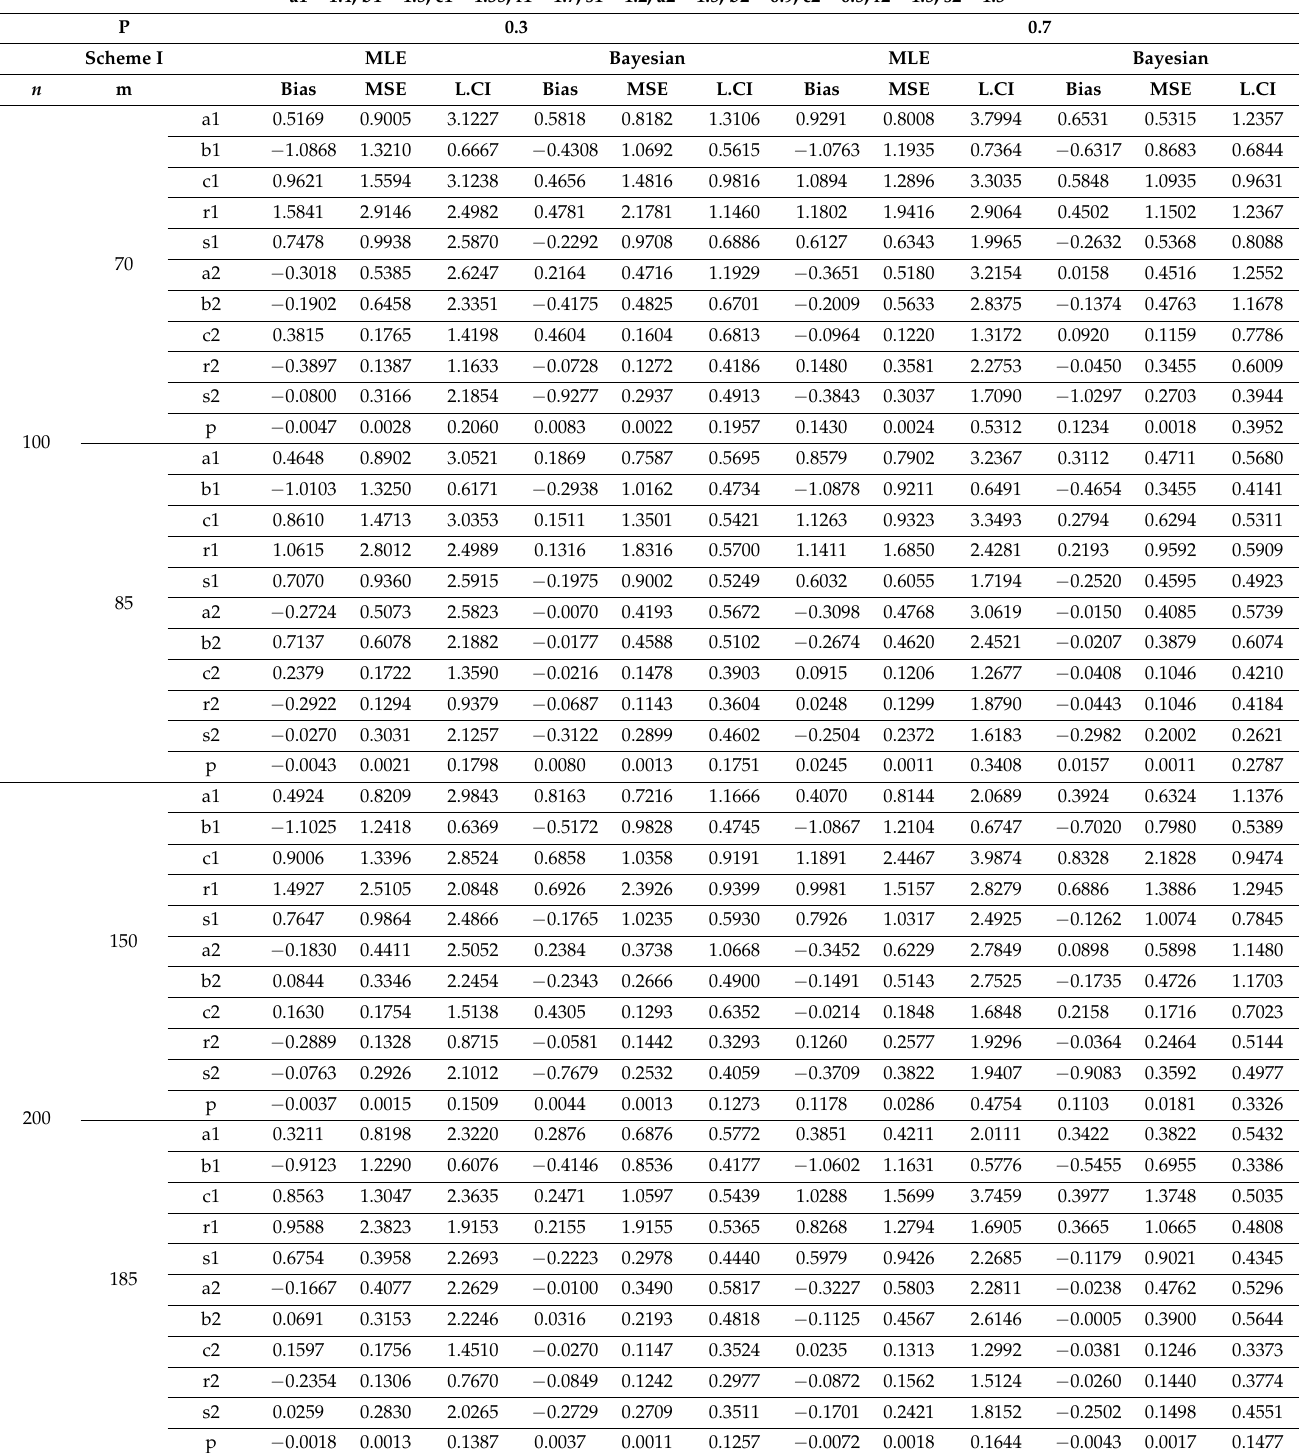
Table 4. MLE and the Bayesian estimates for 11 parameters of MEKGEKF model based on a progres- sively type II censoring. scheme: scheme